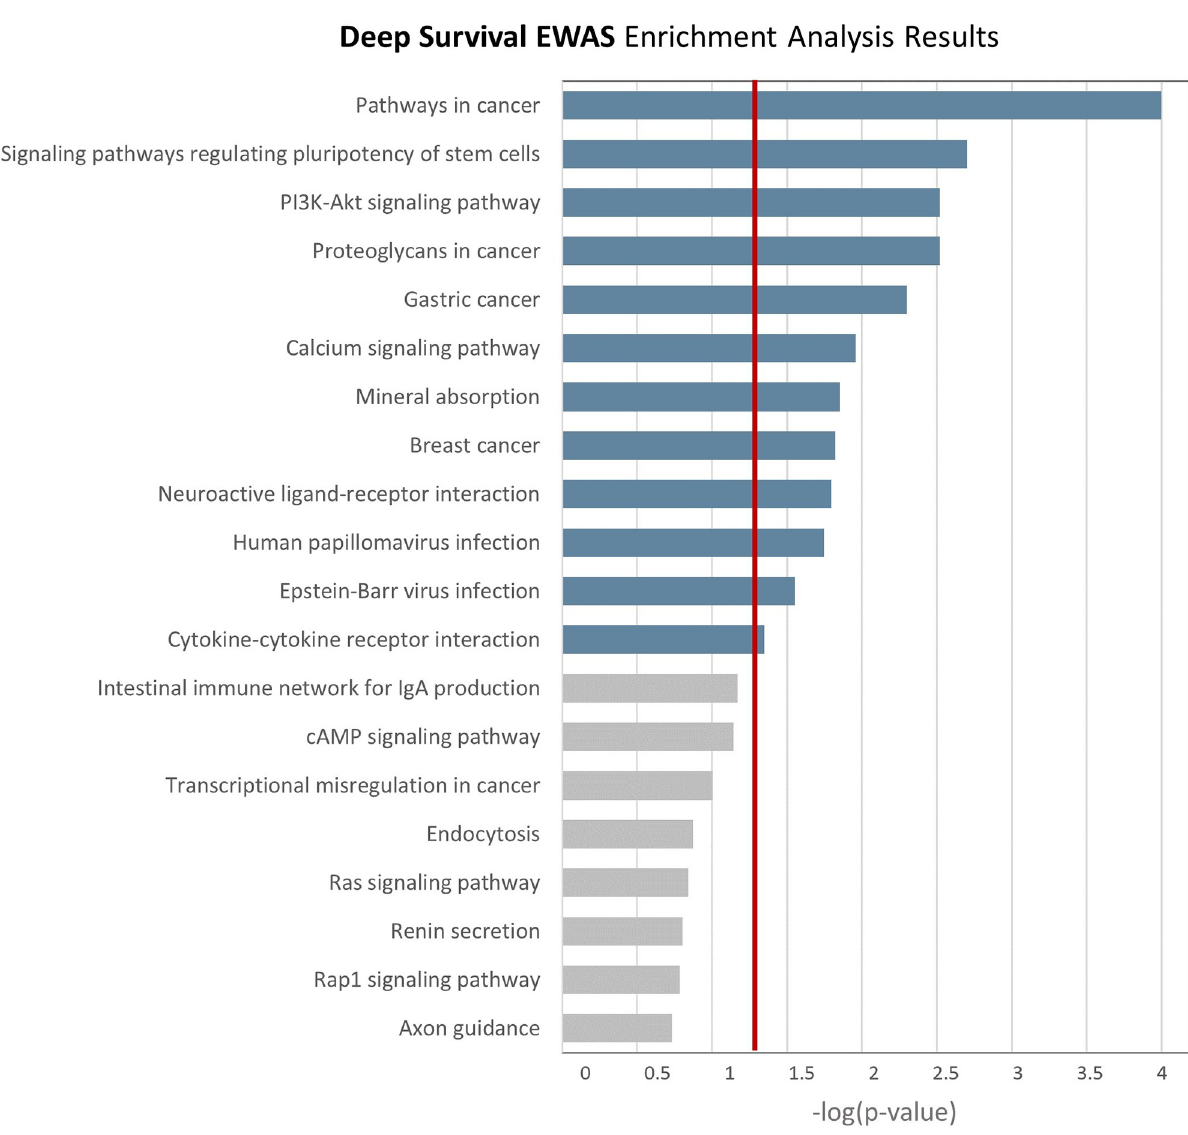
Fig 4. Enrichment analysis results of Deep Survival EWAS on breast cancer controls reference group. In blue are highlighted the significantly associated pathways, i.e. those with empirical p-value above 0.05 (red vertical line), estimated through 10,000 permutations.